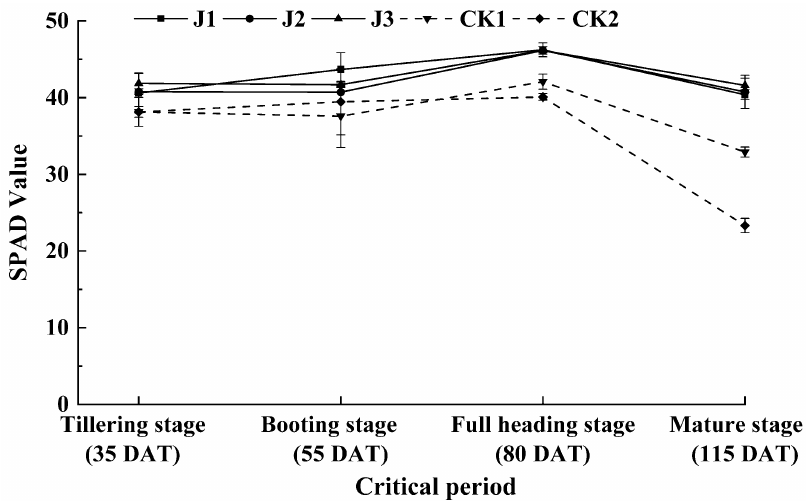
Figure 2. The SPAD value of rice leaves under the applied fertilization